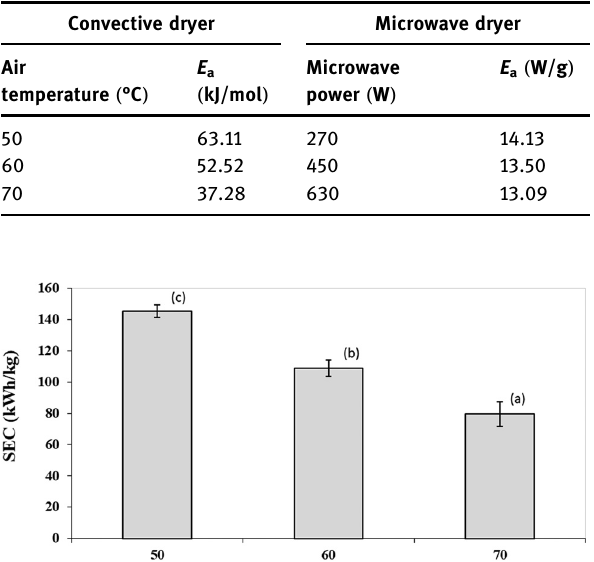
Table 5: Estimated activation energy in CV and MW dryers